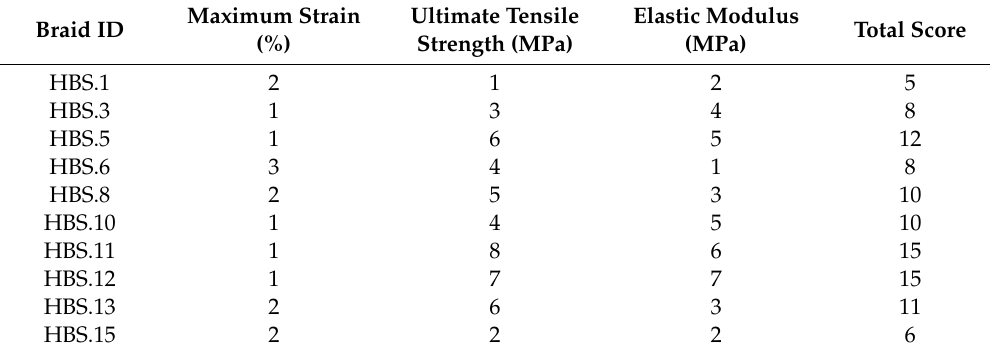
Table 4. Score board of